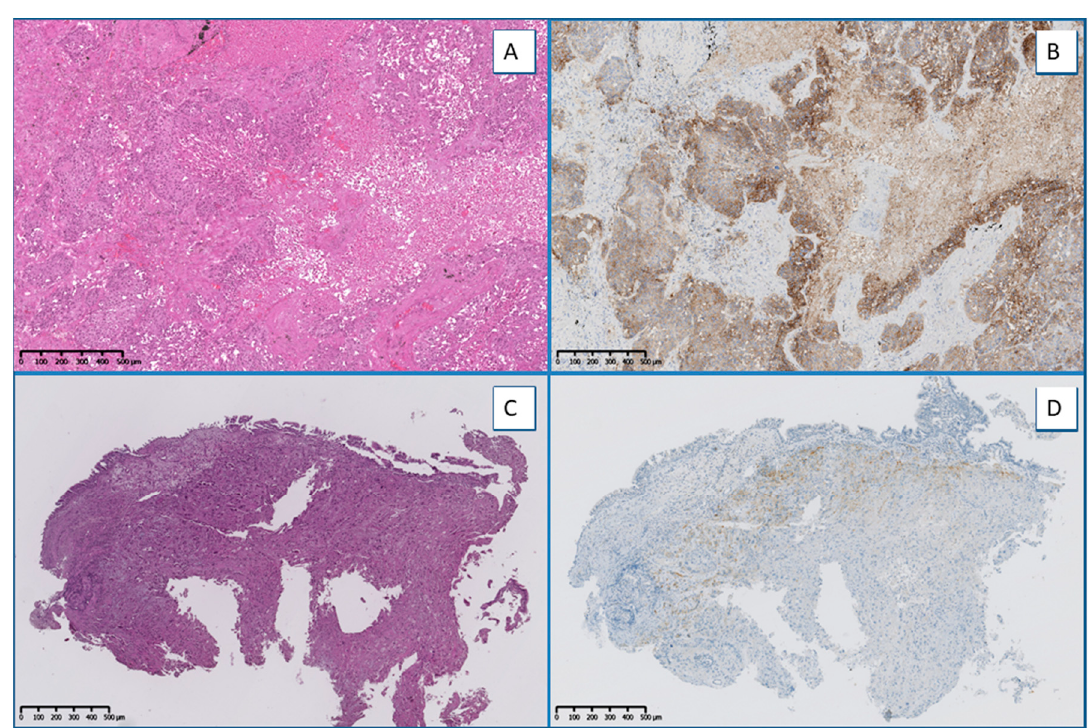
Figure 4. Exemplificative cases of PD-L1 SP263 clone IHC evaluation. Original magnification 5×: ( A ) H and E stained slide with the corresponding PD-L1 evaluation (1–49%, ( B )); ( C ) H and E stained slide with the corresponding PD-L1 evaluation ( ≥ 50%, ( D )).